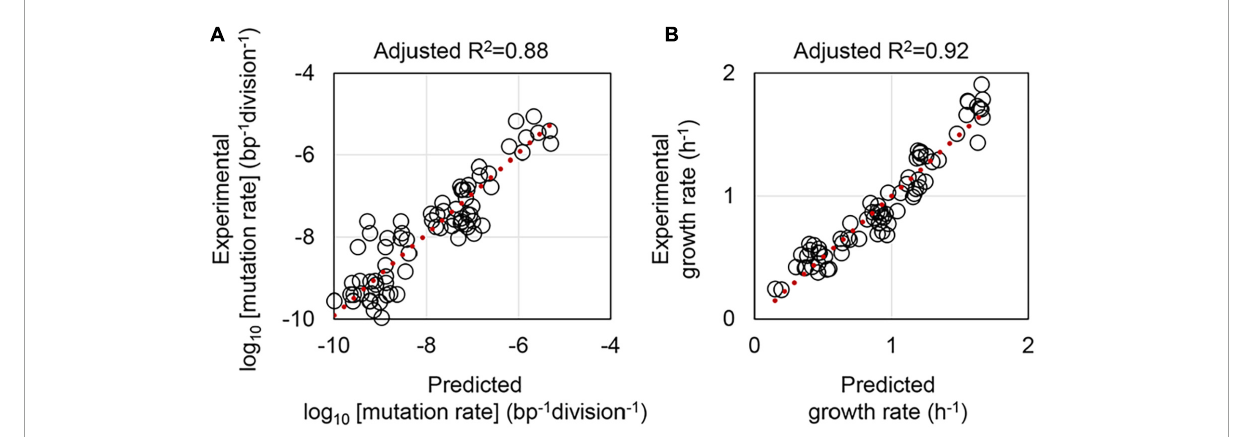
FIGURE5 Prediction of the mutation and growth rates by multiple linear regression. Adjusted R2 denotes the accuracy of multiple linear regression. Red dotted lines indicate the slope of 1. (A,B) Represent the mutation and growth rates, respectively. The corresponding statistics are summarized in Supplementary Table 3